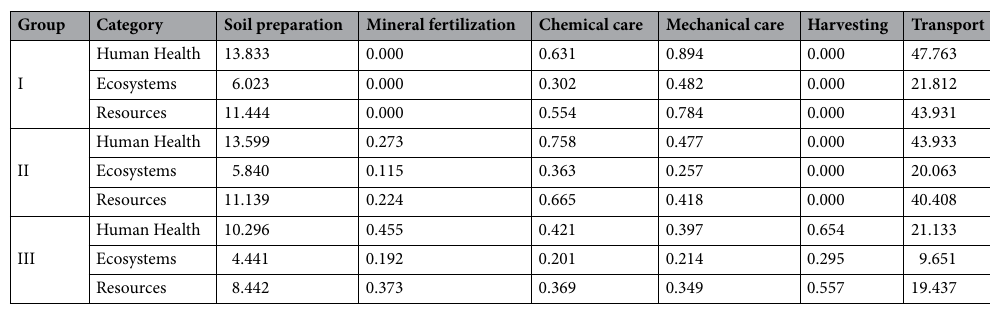
Table 11. The environmental impact of the utilization of technical means of production (processes) as per plantation area (Pt·ha −1